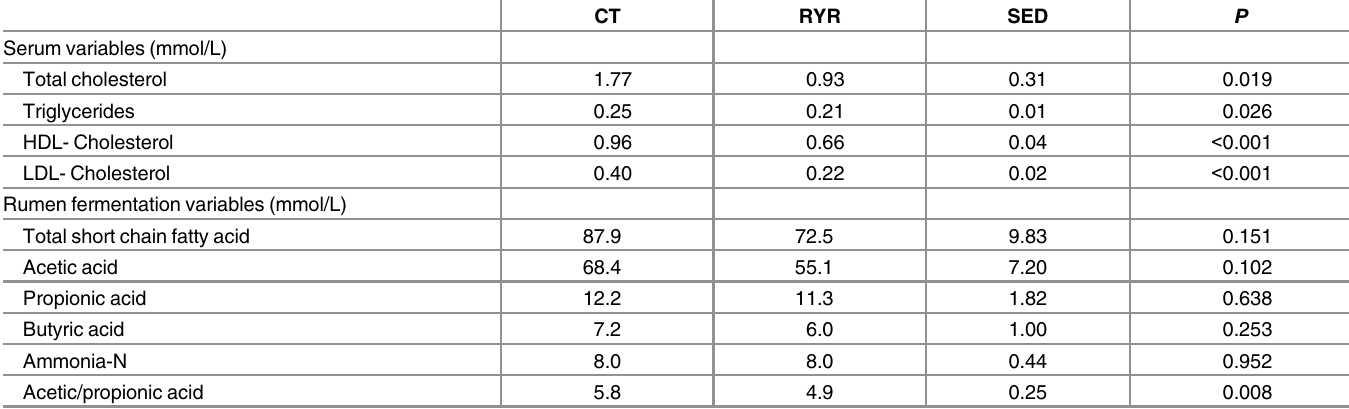
Table 6. The effect of replacement of ordinary rice with red yeast rice on serum lipids and rumen fermentation in goats (n = 20). CT RYR SED